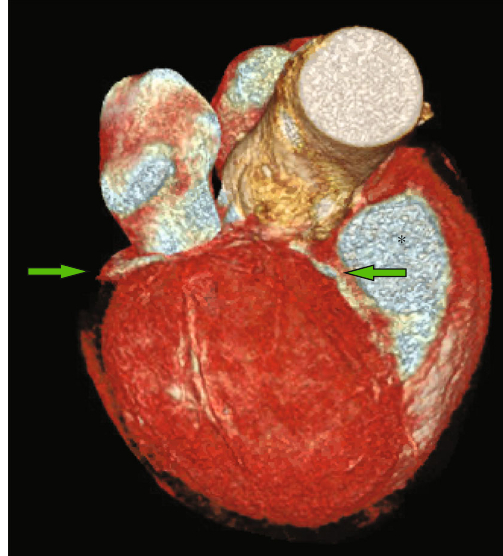
Figure 4: CT coronary showing a large calci fi ed RCA originating posteriorly from the right coronary cusp (green arrow) and a small LAD artery originating from the right coronary cusp into the interventricular groove (green arrow with